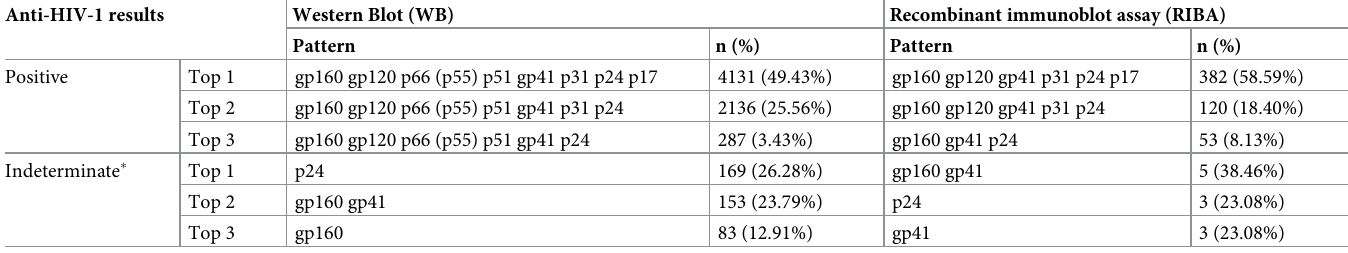
Table 3. Top 3 of the antibodies patterns tested by western blot (WB) or recombination immunoblot assay (RIBA) for the subjects with positive or indeterminate HIV-1 results in Wuhan city, 2012–2018. Anti-HIV-1